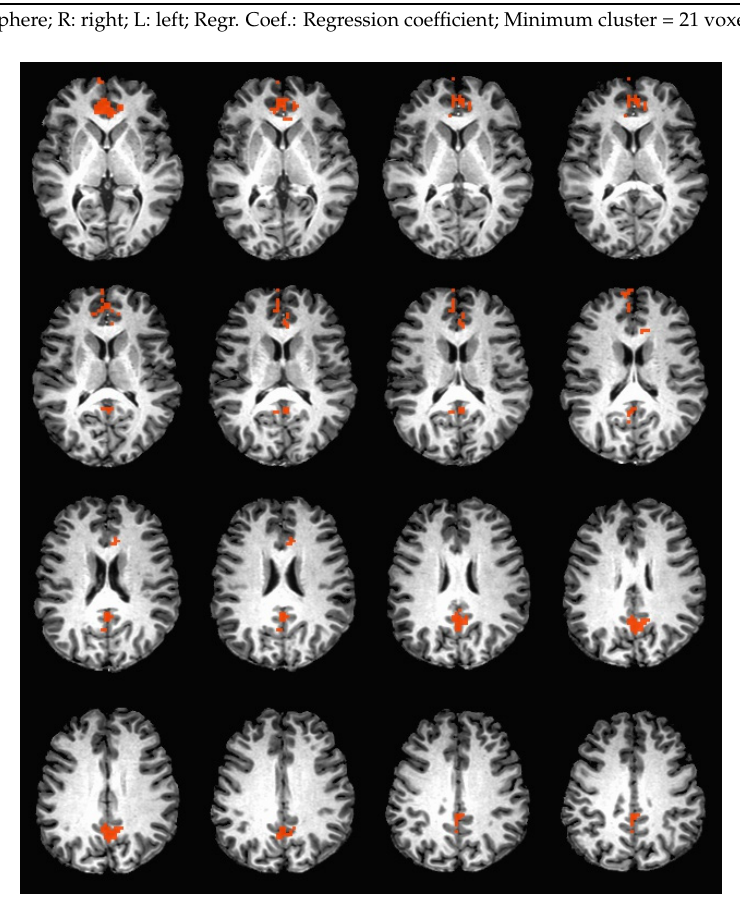
Figure 4. Brain activation during the hedonic evaluation of sucrose. Orange indicates areas where caffeine non-consumers had significantly greater activation in comparison to caffeine consumers.